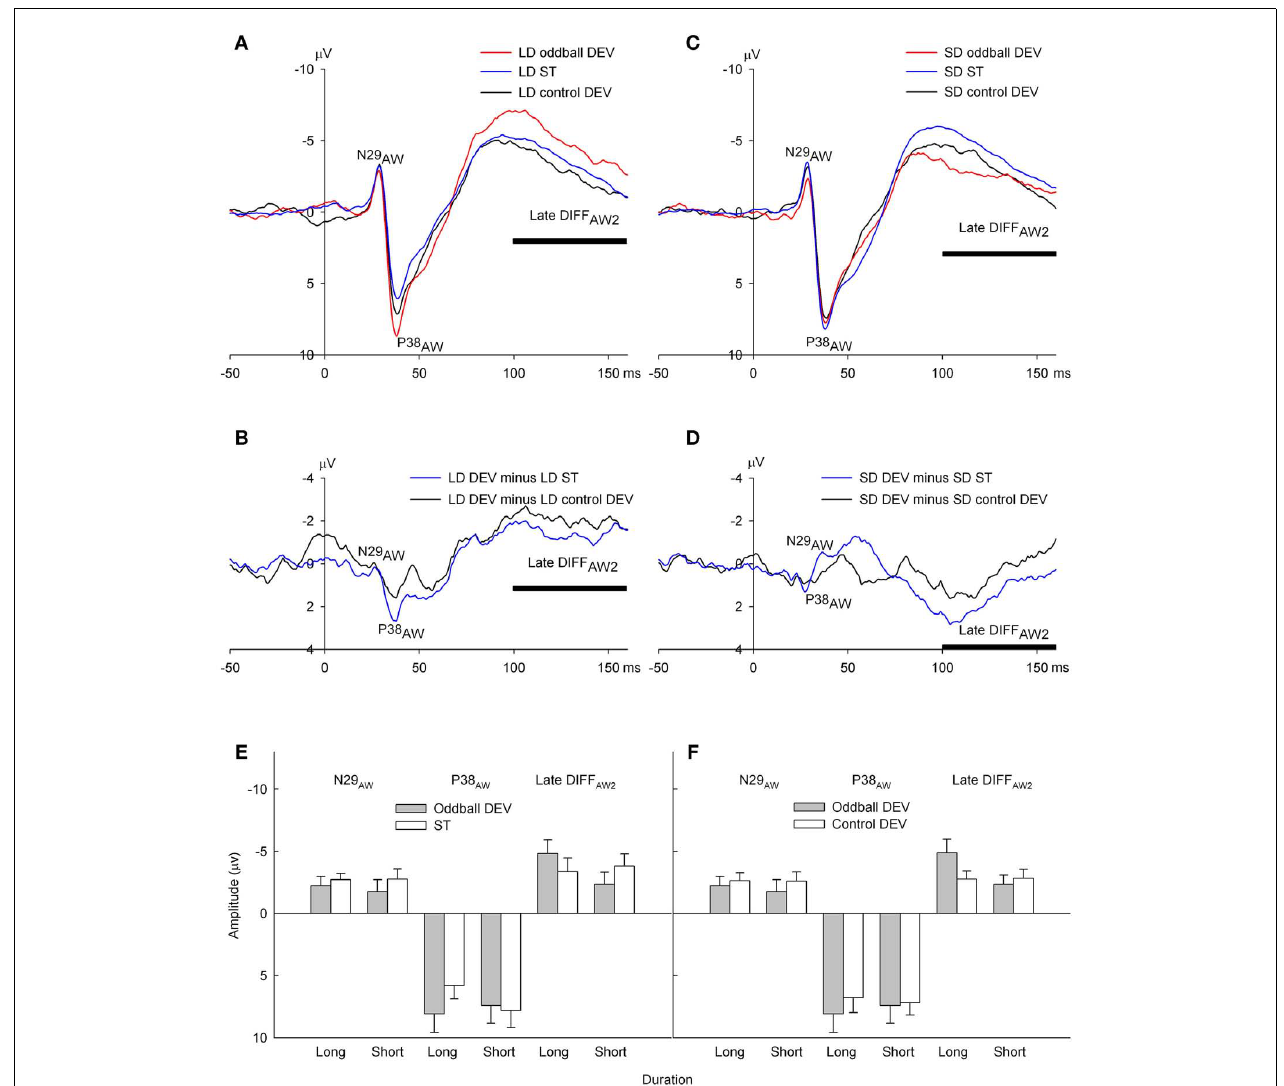
deviance detection. (C) ERPs to short duration (SD) stimuli: N29 AW and P38 AW show no differences between the oddball DEV ERP (red) relative to the SD ST (blue) and relative to the control DEV (black). Over late latencies spanning late DIFF AW2 , the SD oddball DEV shows the opposite pattern to LD oddball DEVs in being positively displaced relative to SD ST and SD control DEV but not significantly so. Note that there is no evidence of the P38 effect evident to LD stimuli. (D) MMN difference waves for SD stimuli: SD oddball DEV minus SD ST (blue), and difference waves derived using control deviants, SD oddball DEV minus SD control DEV (black). (E) The mean amplitude (with SE) of N29 AW , P38 AW , and late DIFF AW2 measures generated by long and short duration oddball DEVs (gray) and STs (white). (F) The mean amplitude (with SE) of N29 AW , P38 AW , and late DIFF AW2 measures generated by long and short duration oddball DEVs (gray) and control DEVs (white).